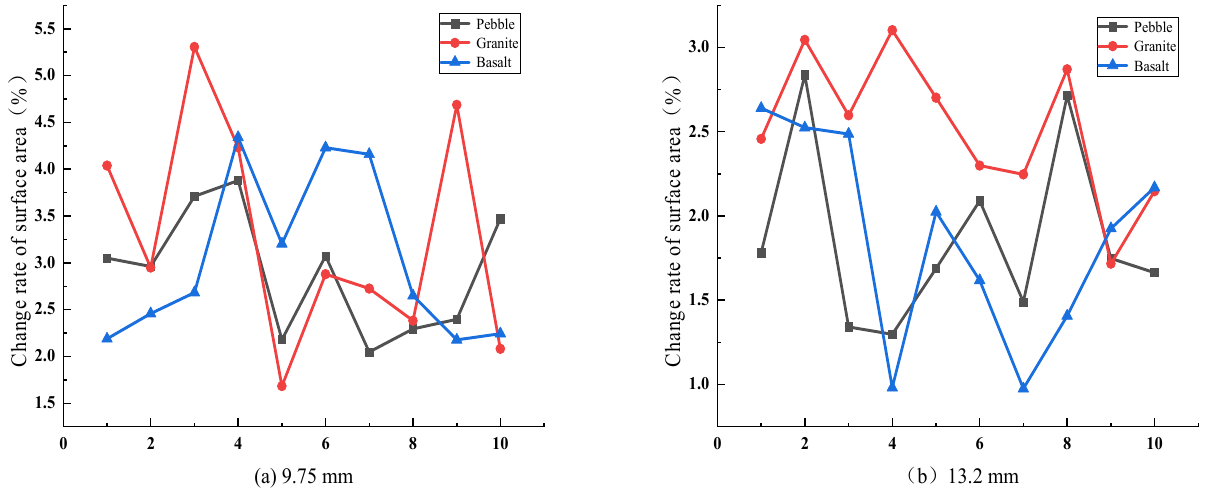
Figure 19. Change rate of surface area of coarse aggregates.